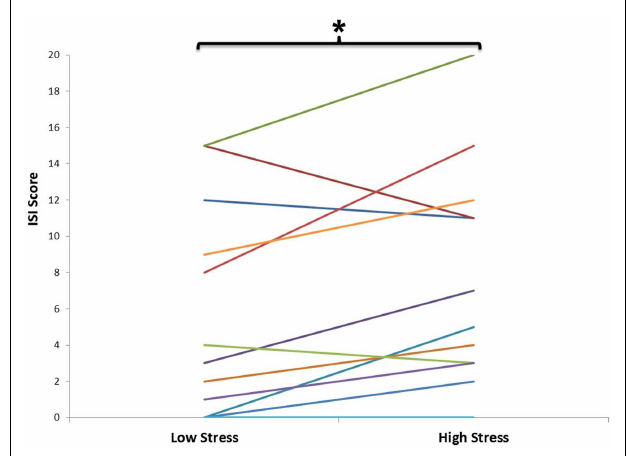
FIGURE 1 | Self-reported sleep quality, as assessed by the insomnia severity index (ISI) during low and high stress periods .This graph depicts the evolution of ISI total score for each individual ( n = 12) from the beginning (low stress period) to the end of the semester (high stress period). Each individual is represented by a different colored line.There was a significant increase in ISI from the low to the high stress period ( p < 0.05).